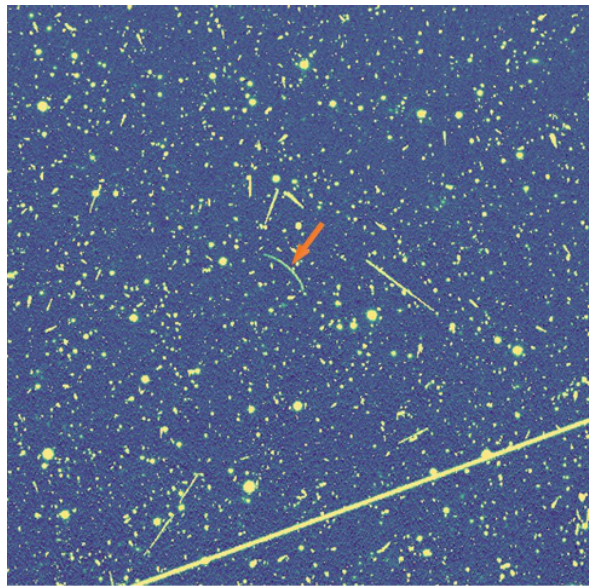
Figure 4. One merged image using max function. The orange arrow shows the trajectory generated by the Near-earth Asteroid CK19D010 on day 128 th of 2019, track 1. only one of them is the trajectory generated by the moving tar- get. Other lines are noises existing in single images.